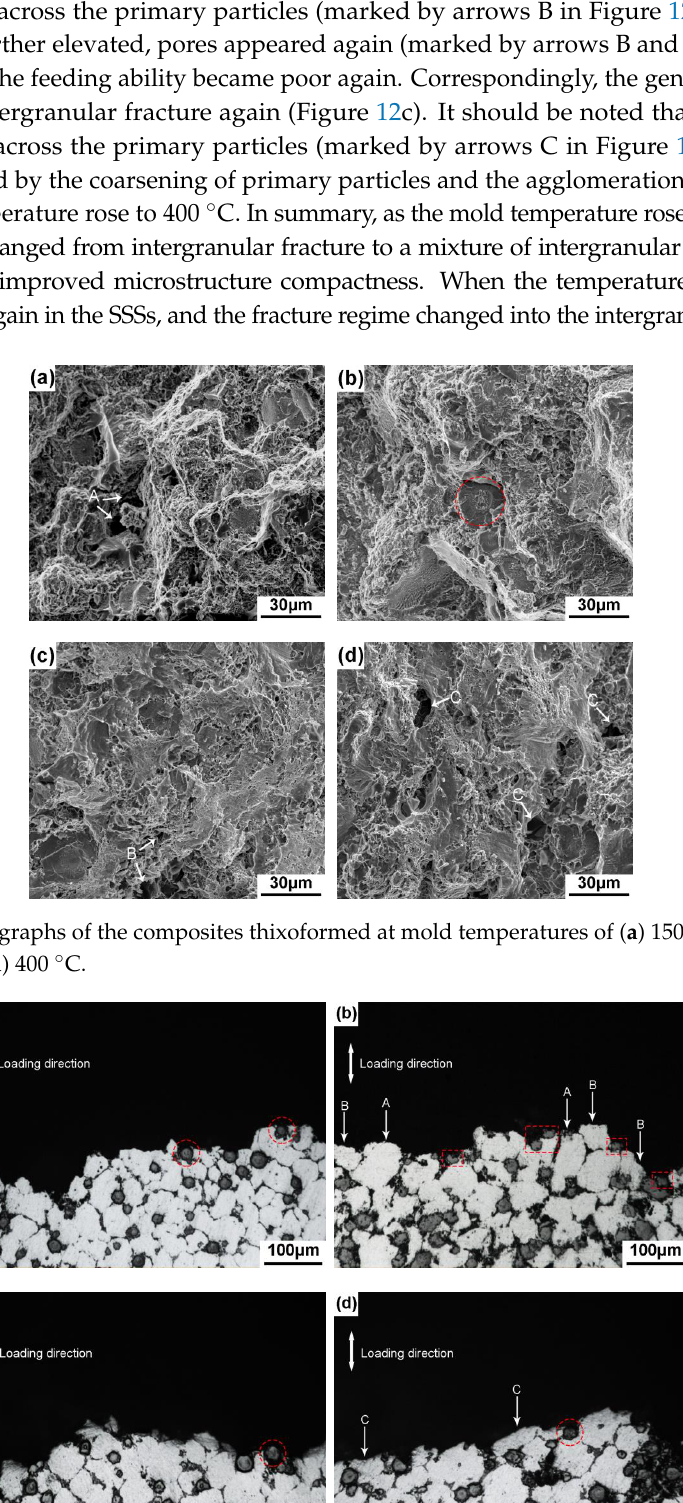
Figure 12. Side views of fracture surfaces of the composites thixoformed at mold temperatures of ( a ) 150 ◦ C, ( b ) 200 ◦ C, ( c ) 300 ◦ C, and ( d ) 400 ◦